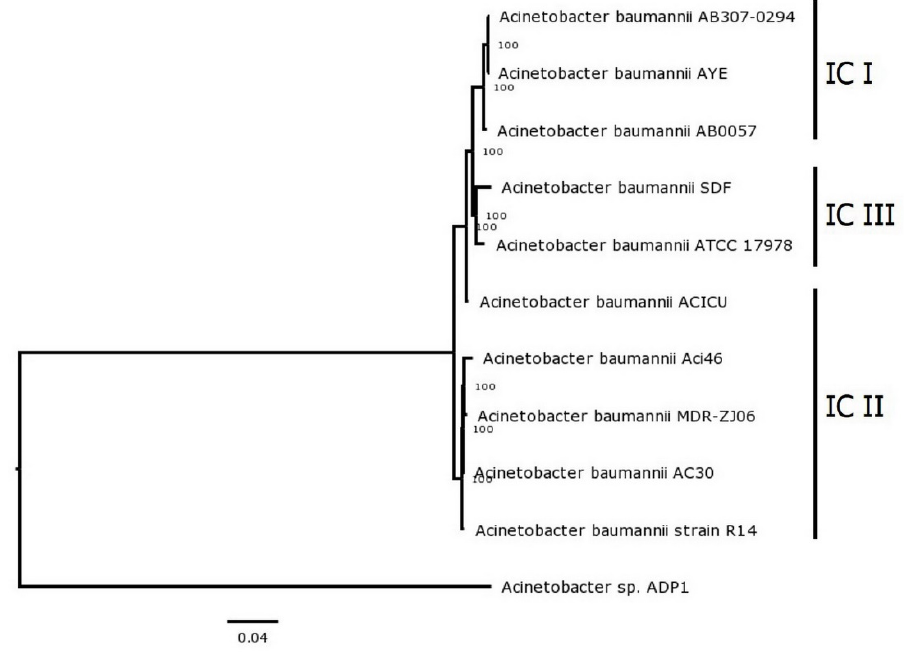
Figure 2. Phylogenetic analysis of A. baumannii Aci46 and ten sequences of A. baumannii genomes for identification of international clonal group (IC). The phylogenetic tree was constructed by RAxML version 8.2.11 using 100 single-copy genes with bootstrap values set to 100 replicates. Selected strains belonging to IC I, IC II, and IC III are labeled. The accession numbers of the strains are as follows: AYE (CU459141.1), AB0057 (CP001182.2), AB307-0294 (CP001172), AC30 (ALXD00000000), ACICU (CP031380.1), MDR-ZJ06 (CP001937.2), R14 (PUDB01000000), ATCC17978 (CP000521.1), SDF (CU468230.2), and A. baylyi ADP1 (CR543861).